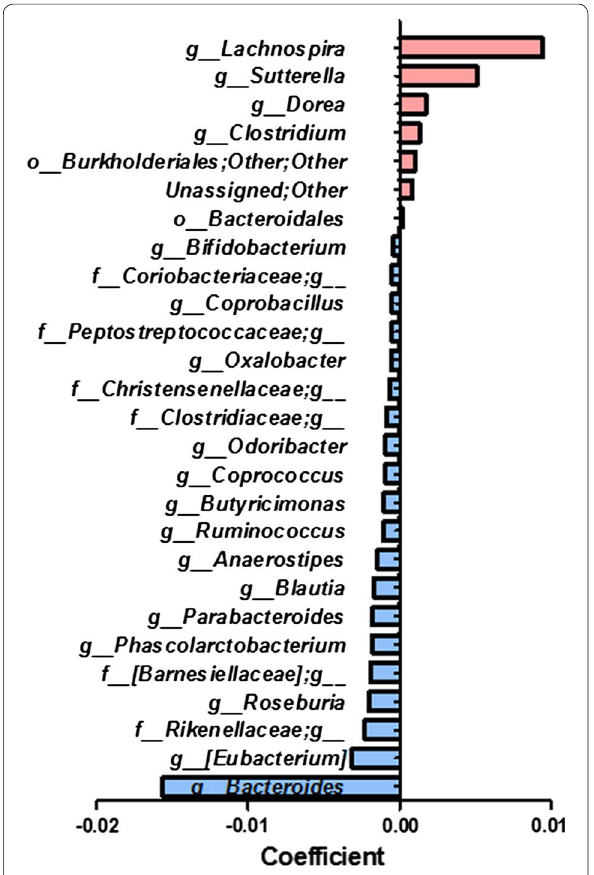
Fig. 4 Significantly changed taxa according to pectin incubation time (q value < 0.1)